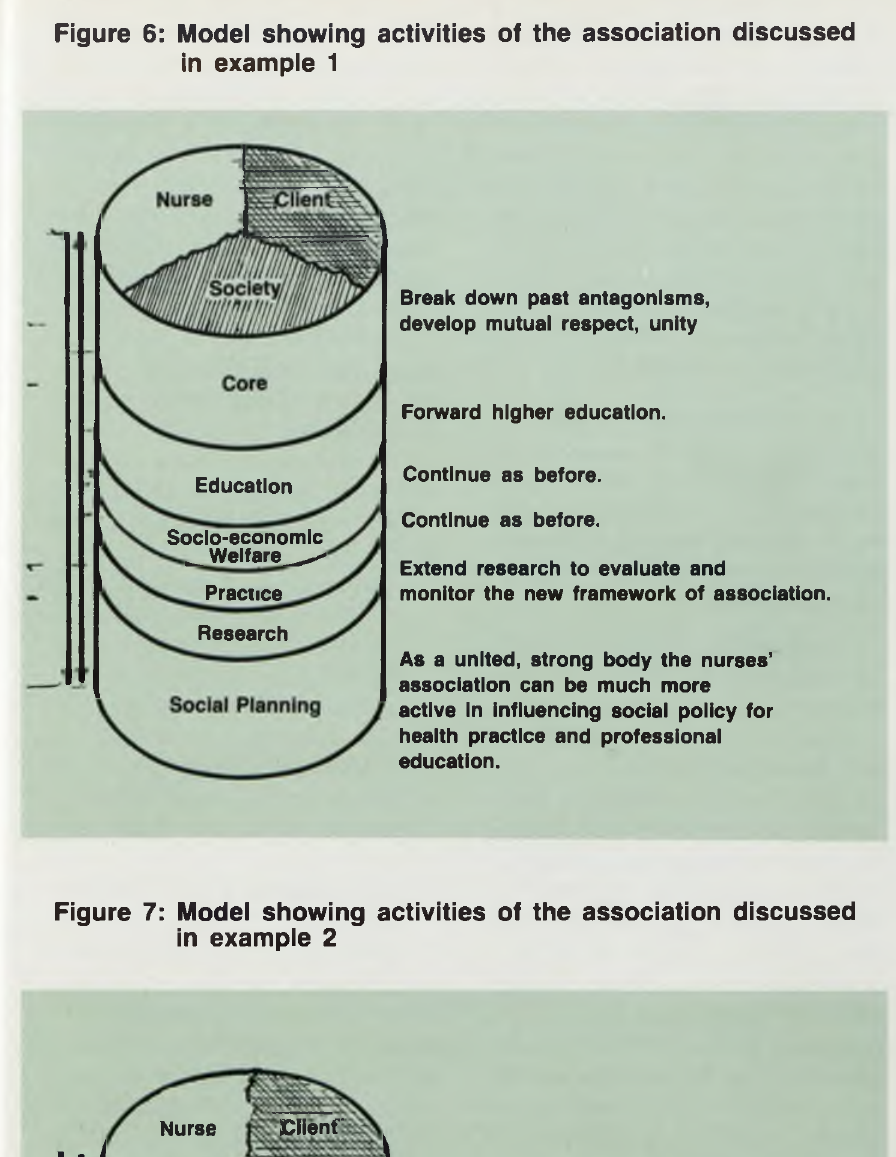
Figure 7: Model showing activities of the association discussed in example